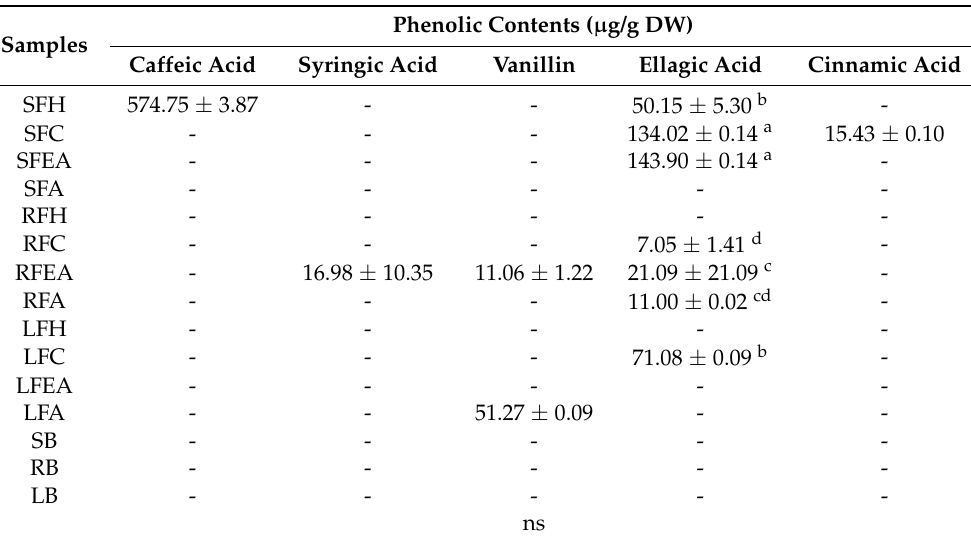
Values presented represent the mean ± SD. Values with no letter in common in each column are not significantly different ( p < 0.05) ( n = 3). Different lowercase letters denote significant differences in the same column; ns: